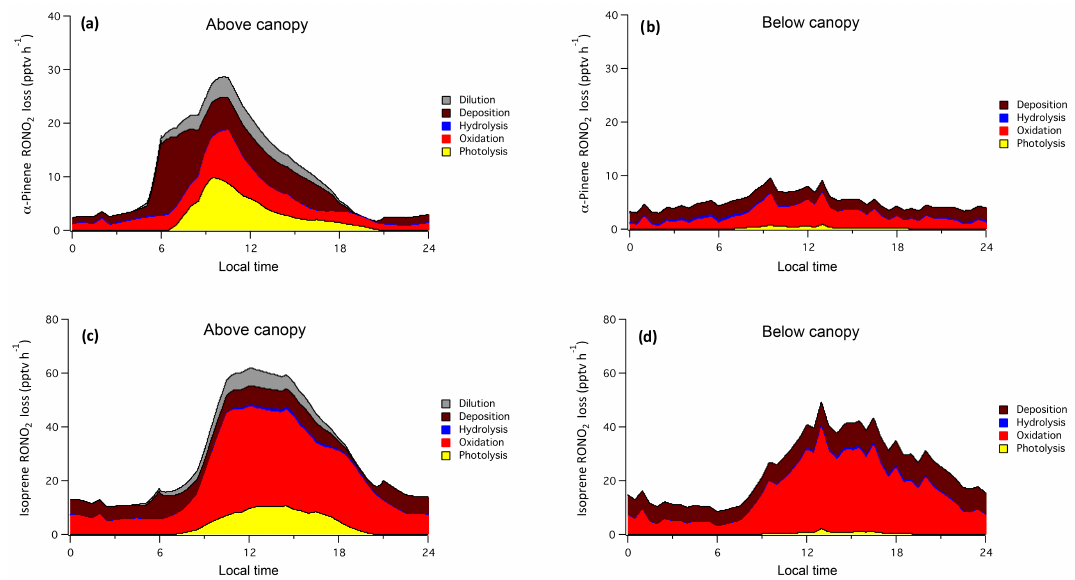
Figure 9. Modeled RONO 2 loss from photolysis (gas phase), oxidation (gas phase), hydrolysis (particle phase), deposition (gas and particle phase), and dilution (gas and particle phase) for (a) α -pinene products above canopy, (b) α -pinene products below canopy, (c) isoprene products above canopy, and (d) isoprene products below